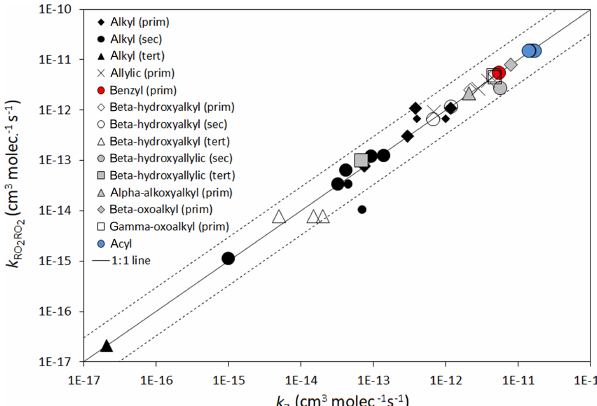
) for 2 RO 2 Figure 5. Scatter plot of rate coefficients for peroxy radical cross- reactions ( k 8 ) with the geometric mean of the self-reaction rate co- efficients (denoted k 7 and k 7 (cid:48) ) for the participating peroxy radicals, RO 2 and R (cid:48) O 2 . Open circles are reactions involving an acyl peroxy radical and a non-acyl peroxy radical; closed circles are reactions involving combinations of primary and secondary peroxy radicals; open diamonds are reactions involving a tertiary peroxy radical and a primary or secondary peroxy radical. The heavy broken line is a 1 : 1 relationship; the light broken line is a 2 : 1 relationship;